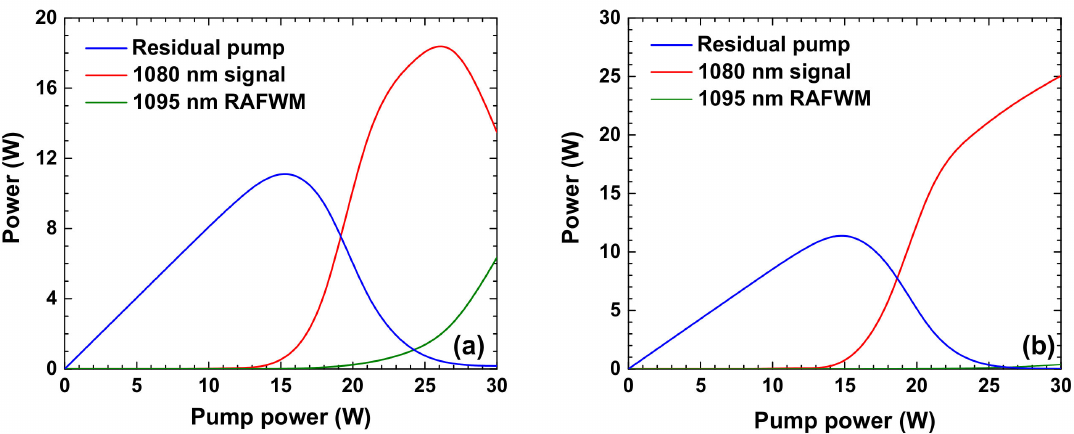
Figure 2. The power evolution characteristics of the Raman-assisted FWM process in the ( a ) forward- pumped low-QD Raman amplifier and ( b ) backward-pumped low-QD Raman amplifier. RAFWM, Raman-assisted four-wave